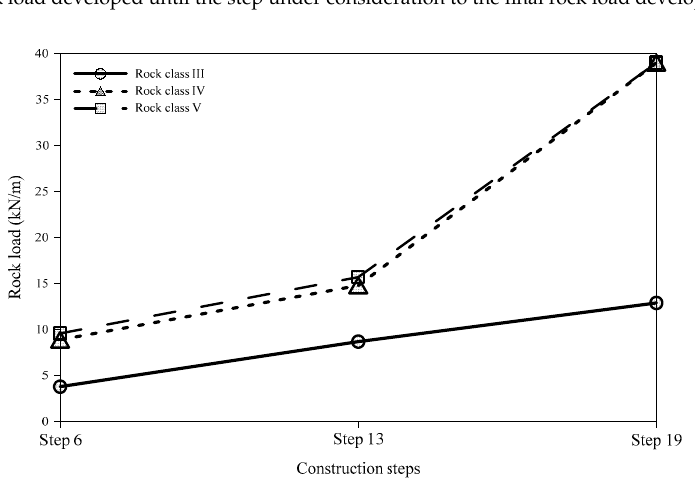
Figure 16. Rock load development during various construction steps.